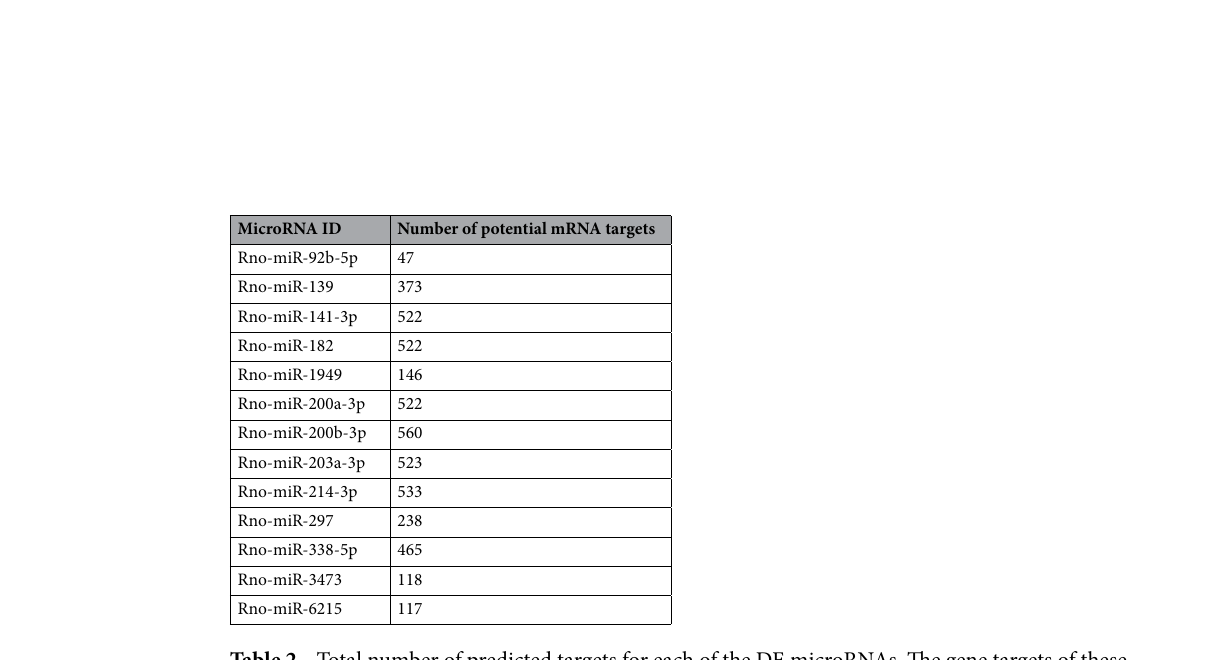
Table 2. Total number of predicted targets for each of the DE microRNAs. The gene targets of these microRNA were determined using the Rattus Norvegicus microRNA targets as listed in miRDB